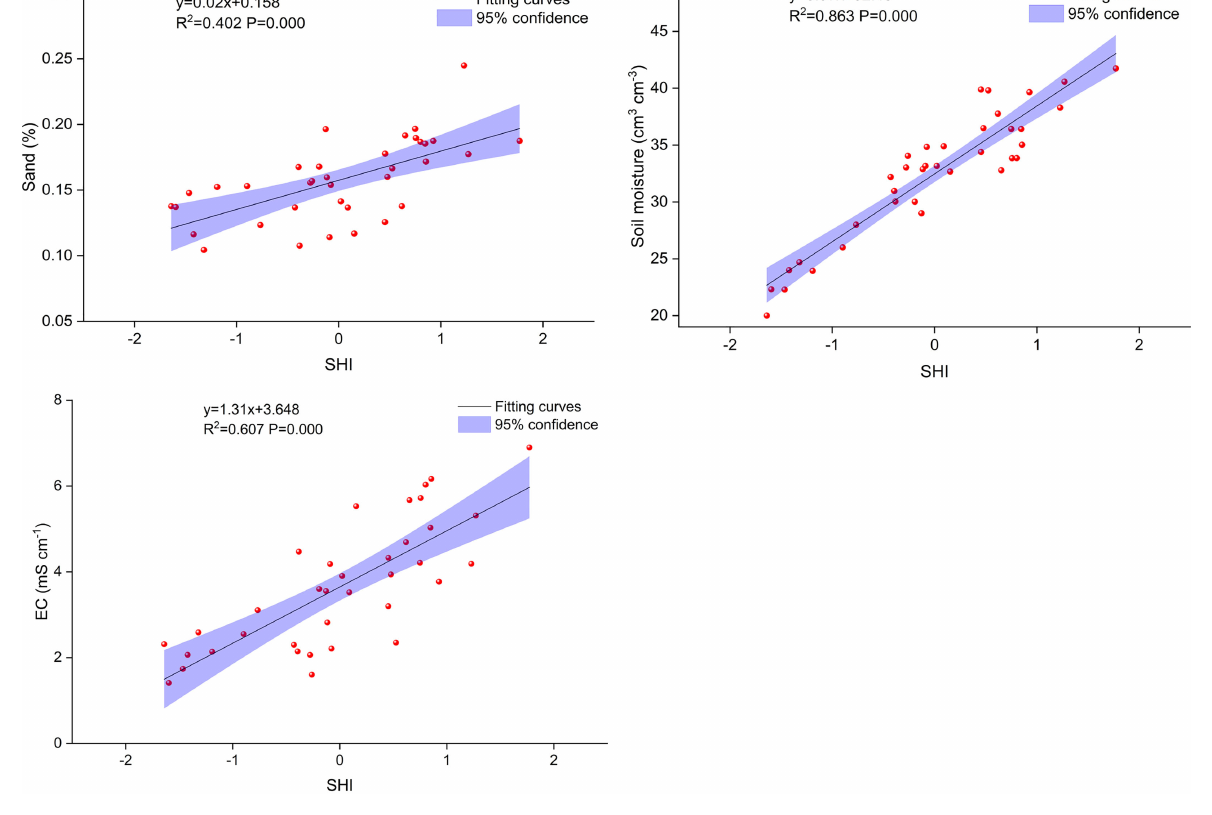
FIGURE 3 Relationship between soil properties and soil habitat index (SHI) in Tamarix chinensis